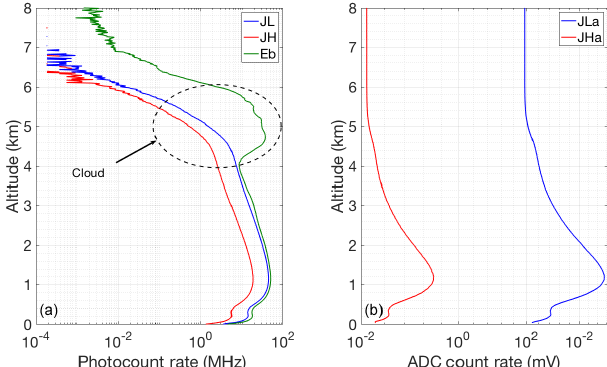
Figure 17. Count rate for 30min of coadded RALMO measure- ments from 23:00UT on 21 June 2011, which has a cloud base at an height about 4km; (a) Photon-counting channels (blue curve, JL; red curve, JH; green, Elastic); (b) Analog channels. Figure 18. Difference between the forward model and the nighttime RALMO measurements on 21 June 2011 with the presence of a lower level cloud for the four signals (blue). The red curves show the standard deviation of the